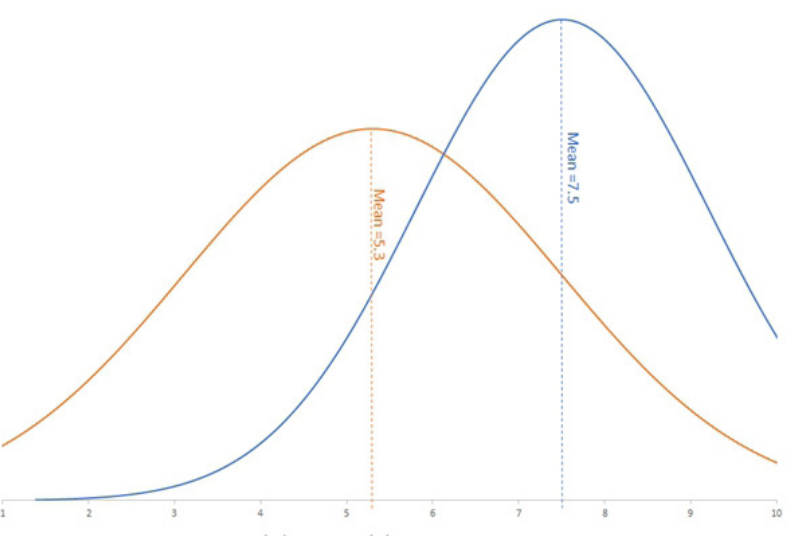
Figure 8. Distribution of detail-focus scores for general (red line, AQ is less than 32) and ASC (blue line, AQ is 32 or higher) population, based on data from a large scale population study of 1062 participants. The ASC population is substantially smaller than the neurotypical population in the general population (typically about 4% of the total). When adjusted for a natural population representation of ASC our data showed that at least 1 in 3 individuals at the highest detail score (highest level of local processing bias) would also have an